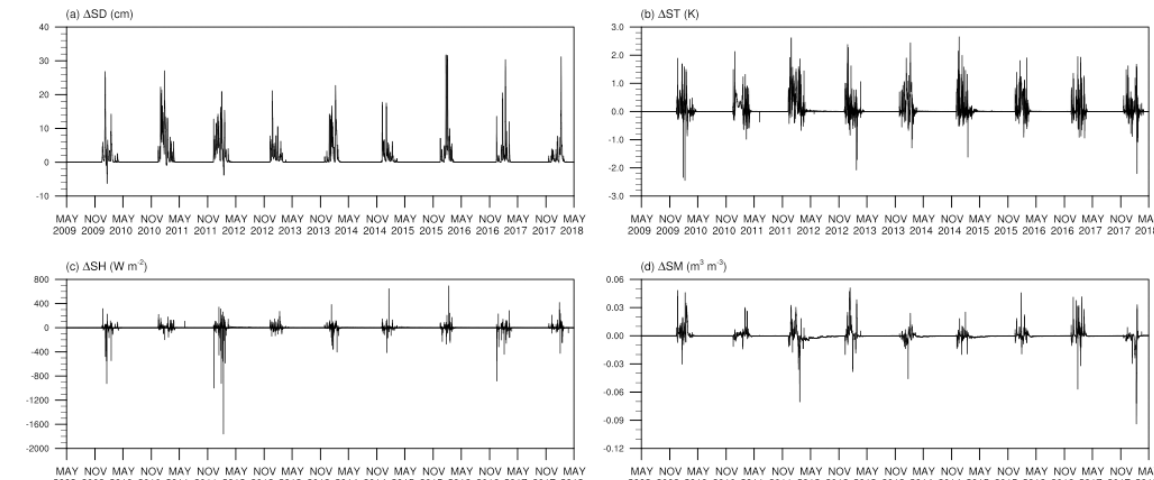
Figure 8. Time series of the difference between CNTL and VRF_6 for the UL in DBF from May 2009 to April 2018: (a) SD (cm), (b) soil temperature in the top soil layer (7cm) (ST; K), (c) sensible heat flux (SH; Wm − 2 ), and (d) soil moisture in the top soil layer (7cm) (SM; m 3 m − 3